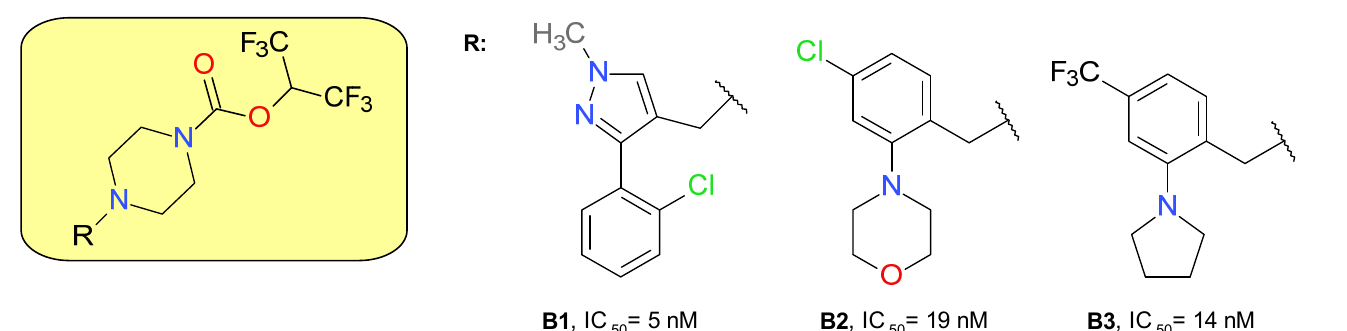
Figure 4. Irreversible MAGL inhibitors—piperazine carbamate derivatives.